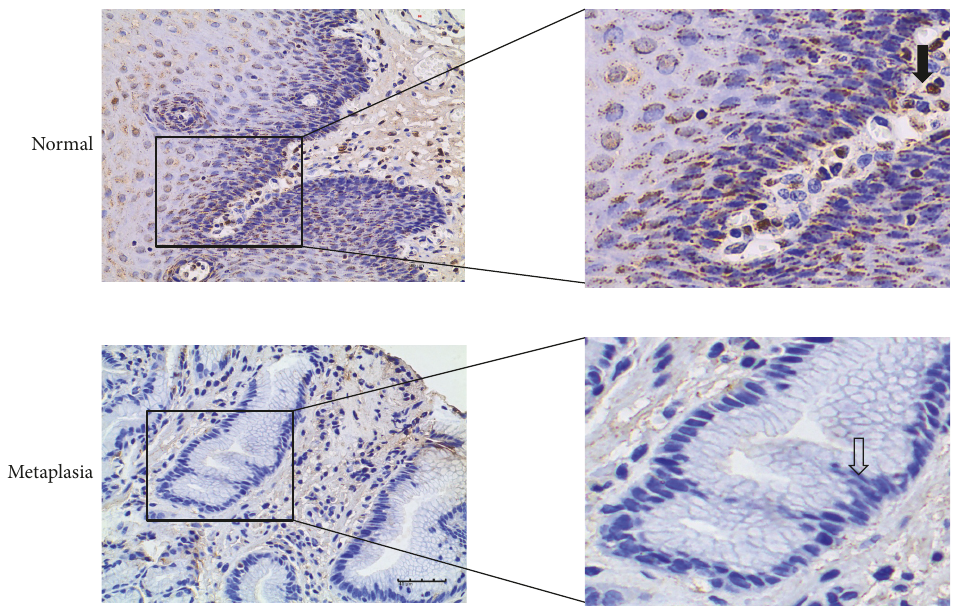
Figure 2: Representative Hes1 immunohistochemical staining in samples with different histological alterations. Intense Hes1 protein was mainly expressed in cytoplasm and nucleus of normal esophageal cells, and metaplastic columnar cells mainly exhibited negative staining (arrows). Scale bar in the figure is 40 𝜇 m. Magnified figures were shown in the right side.